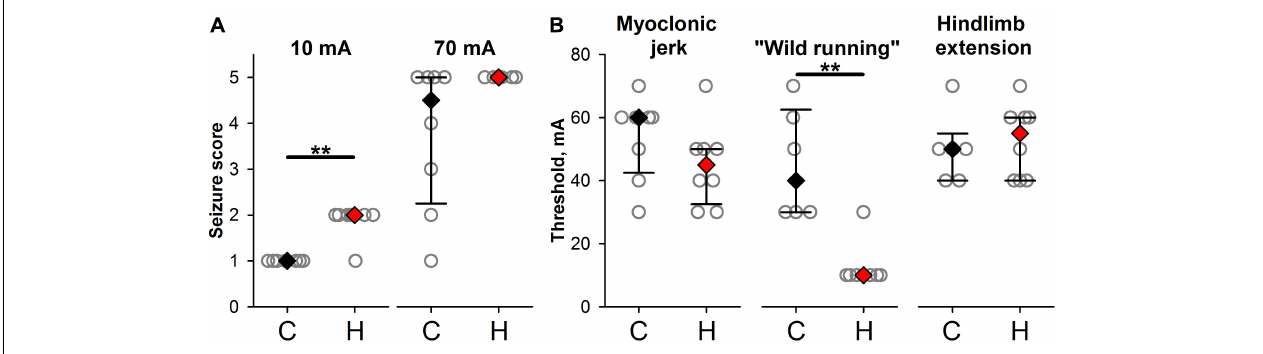
FIGURE 7 | Effects of prenatal hypoxia exposure on seizure reactions in response to dosed electroshock. (A) The seizure scores in response to minimal and maximal ECS used in the experiment in control (C) and hypoxic animals (H). (B) The threshold amplitudes of electroshock inducing convulsions of different types. ** The difference between the groups at P < 0.01 according to the Mann–Whitney